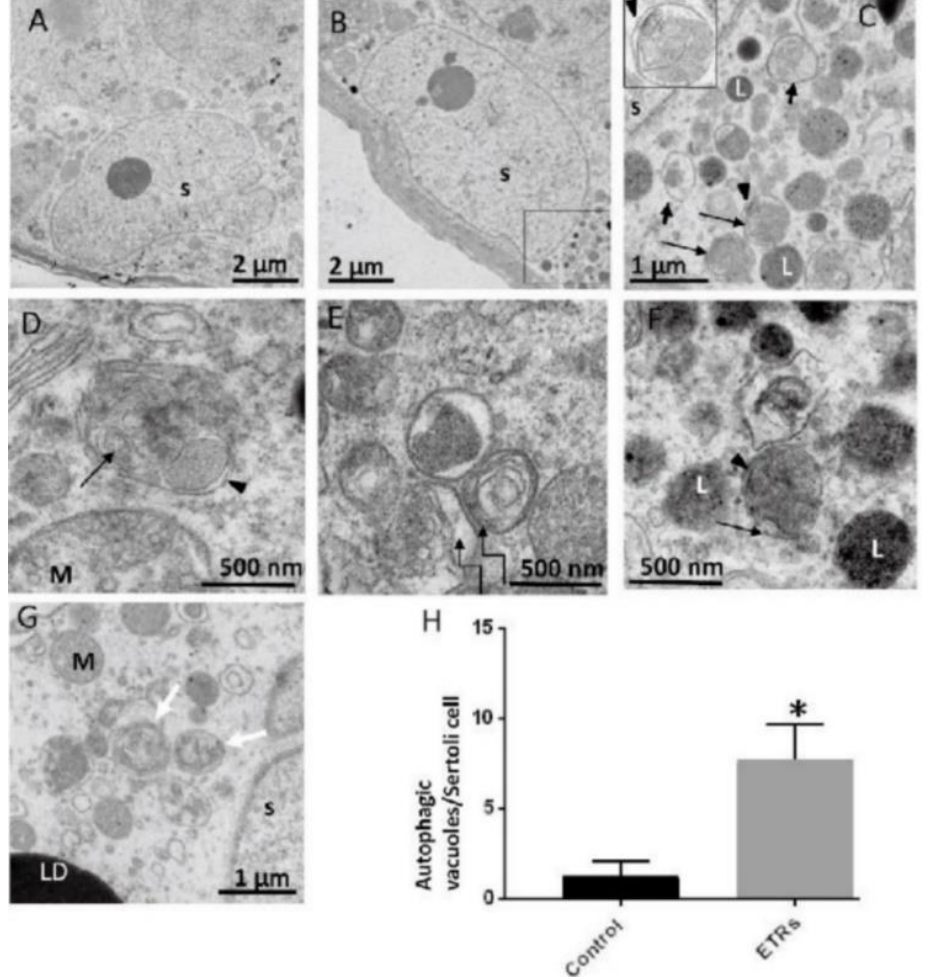
Figure 2. Ultrastructural features of upregulated autophagy in ethanol-treated Sertoli cells (ETR SCs). TEM of the control ( A ) and ETRs ( B – G ). The histogram ( H ) shows a significant increase in the number of autophagic vacuoles (AVs) in ETR SCs. The long black arrows indicate autophagosomes with a double limiting membrane (arrow heads) (magnified in the inset in ( C )). The short arrows indicate autolysosomes. The broken arrows in ( E ) show multilamellar bodies, while the white arrows in ( G ) show autophagosomes containing fragmented mitochondria. Note the characteristic perinuclear localization of AVs. S: SC nucleus; L: lysosome; M: mitochondria; LD: lipid droplet. AVs include autophagosomes and autolysosomes. * p < 0.05. This was reprinted from Reference [3].